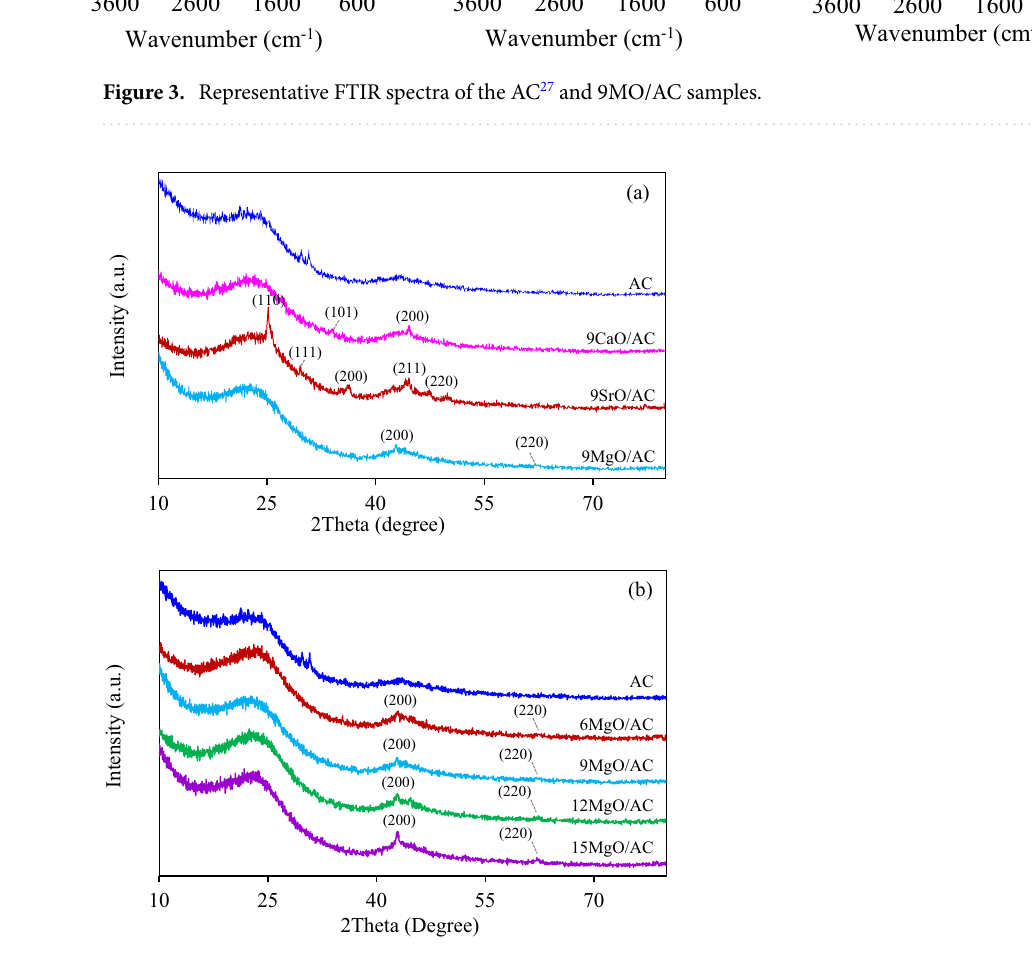
Figure 4. Representative XRD pattern of ( a ) 9MO/AC and ( b ) x MgO/AC